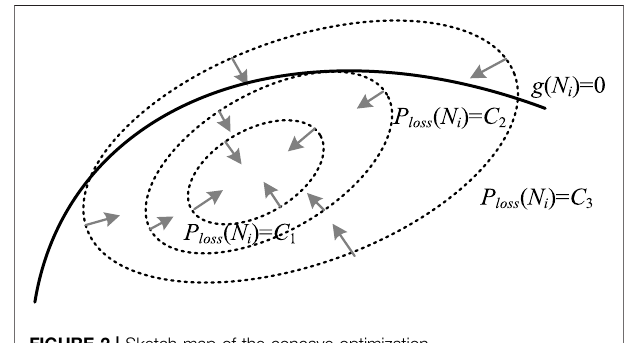
FIGURE 2 | Sketch map of the concave